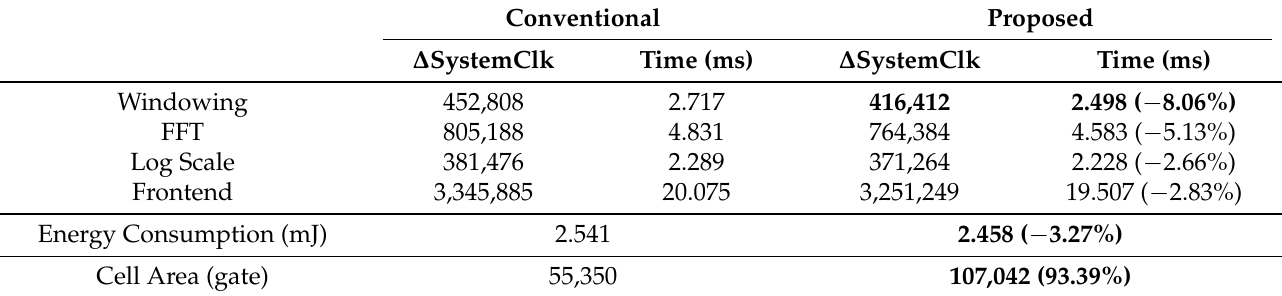
Figure 7. Synthesis result cell area comparison according to Hann window coefficient length and quantize precision degree. ( a ) Design Compiler synthesis result according to coefficient length and quantization degreeu ( b ) FPGA synthesis result with the smallest cell area ( c ) FPGA synthesis result with the largest cell area. Table 2. Comparison of time, energy, and the logic area between the conventional and proposed